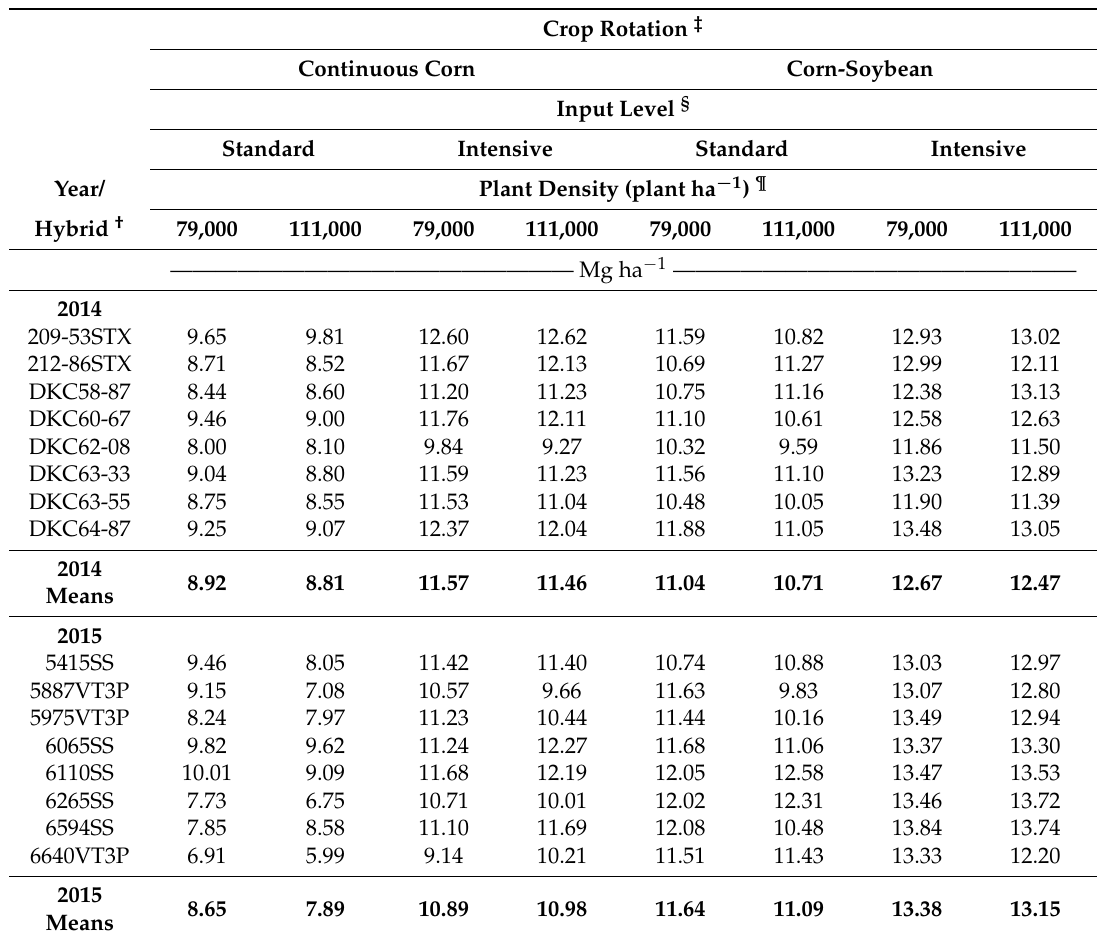
Table 5. Corn grain yield for hybrids as influenced by crop rotation, agronomic input level, and population. Hybrids were grown in continuous corn and following soybean rotations at Champaign, IL in 2014 and 2015. All values are reported at 0 g kg − 1 moisture